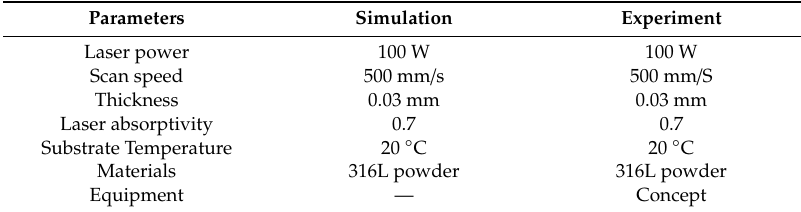
Table 2. Simulation process parameters and laser energy values.